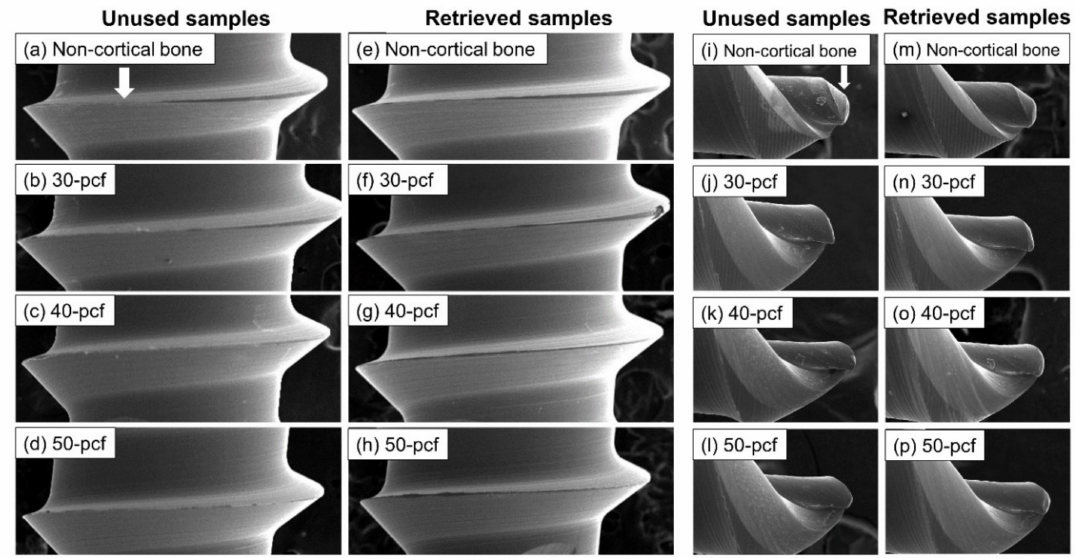
Figure 8. SEM images of miniscrew thread (40 × magnification) and tip (200 × magnification), namely ( a – d ) thread of unused samples, ( e – h ), thread of retrieved samples, ( i – l ) tip of unused samples, and ( m – p ) tip of retrieved